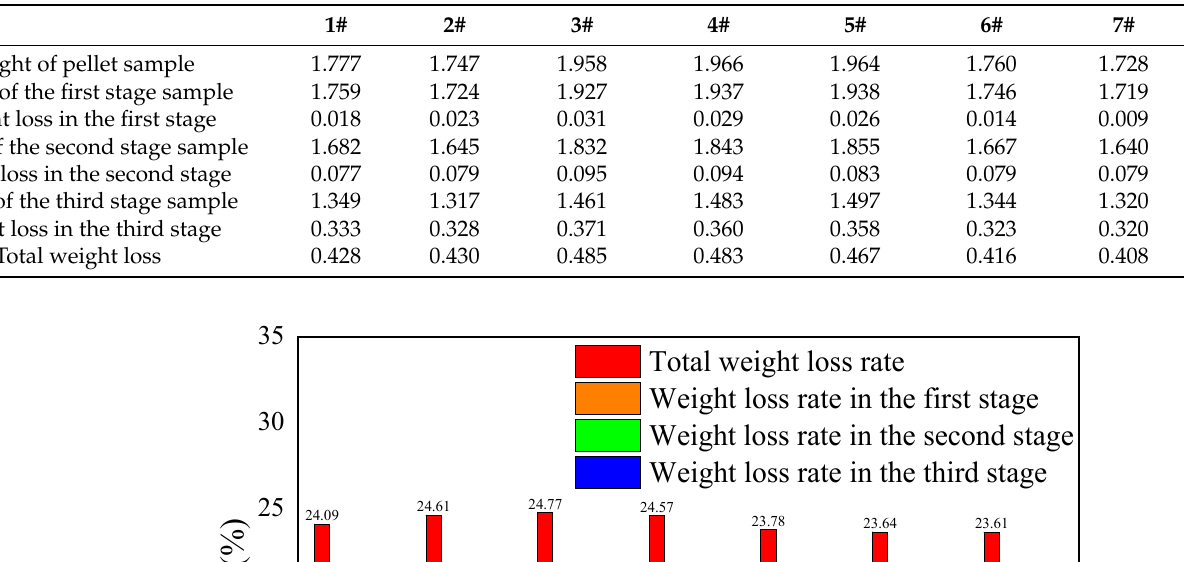
Table 8. Pellet samples with different basicities lose weight at each stage of reduction / g .